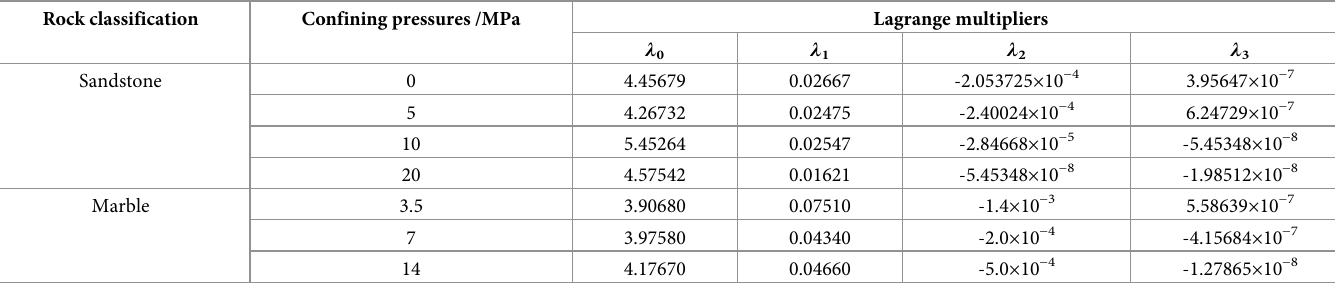
Table 2. The calculated Lagrange multipliers under different confining